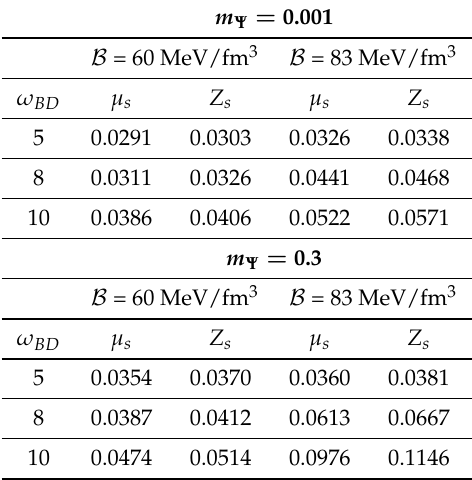
Table 4. Values of µ s and Z s for different values of m Ψ , B and ω BD corresponding to PSR J1614-2230 ( M = 1.97 ± 0.04 M (cid:74)